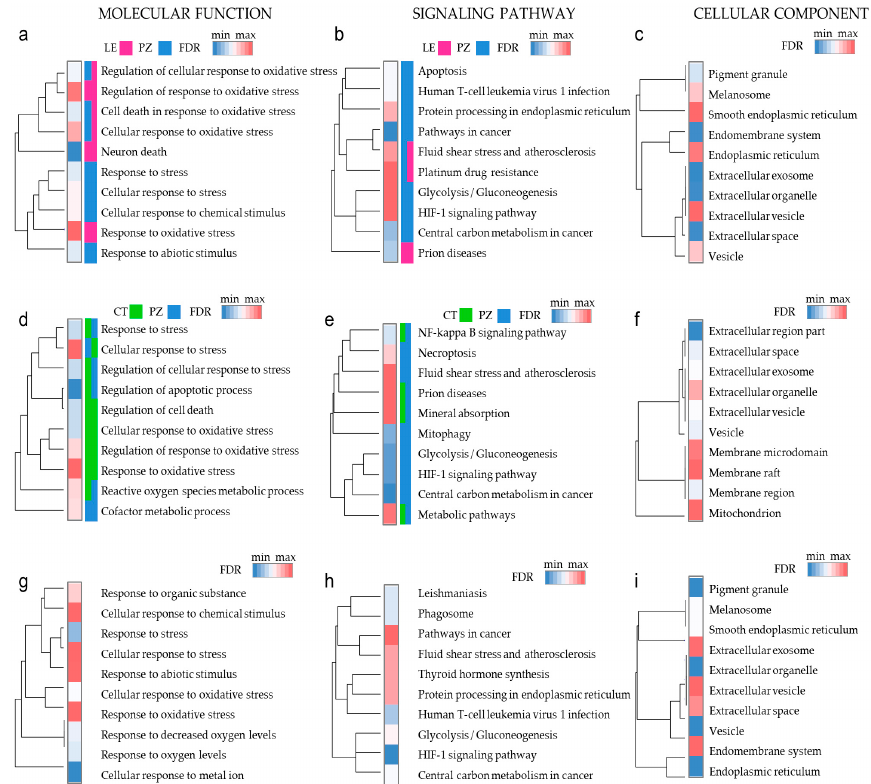
Figure 4. Gene Ontology analysis reveals activation of distinct pathways in diverse anatomic features of glioblastoma: Function of top-20 ( a – f ) and 29 outcome predictive gens ( g – i ) represented as Gene Ontology tree in indicated categories. Color bars ( a , b , d , e ) represent an enrichment of upregulated genes from different anatomic tumor features (LE-pink, CT-green, PZ-blue), a single-color square indicates activation of unique pathways, and a two-color square indicates shared pathways. FDR values are shown as a heat map, with red maxim and blue minimum.